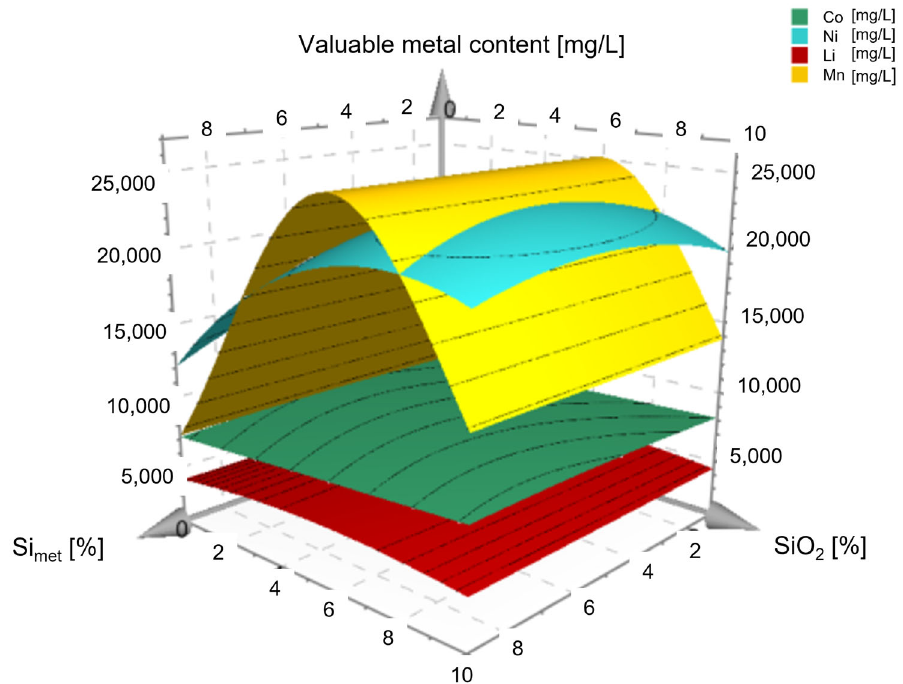
Figure 13. Surface plots for Ni, Co, Li and Mn leaching and their dependencies on the SiO 2 and Si met content of the leaching solution.